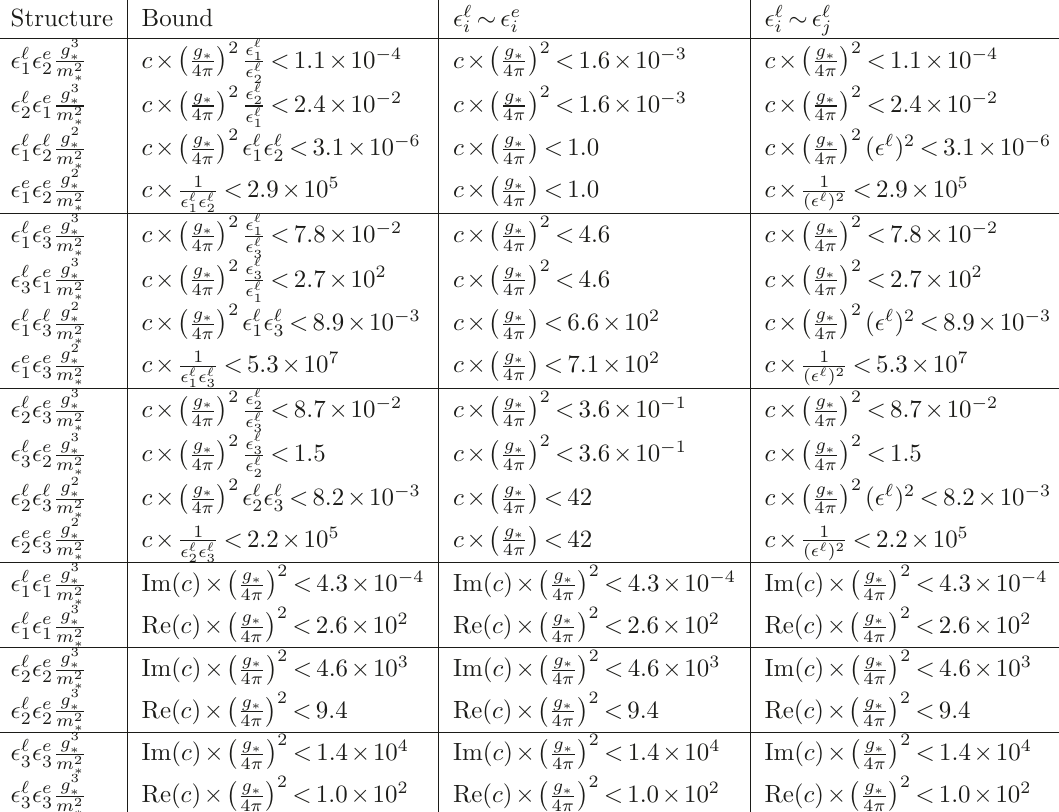
Table 6 . Bounds on the coefficients of the anarchic scenario (i.e. the matrices c are anarchic, complex, order one) for m ∗ = 10 TeV. In the first column we show the combination of parameters that is constrained, and in the second we used eq. (2.8) to remove redundant mixing parameters. The flavor and operator indices of the coefficients c are understood. In the last two columns, the bounds are specialized to two phenomenologically relevant limits: left-right symmetry and left